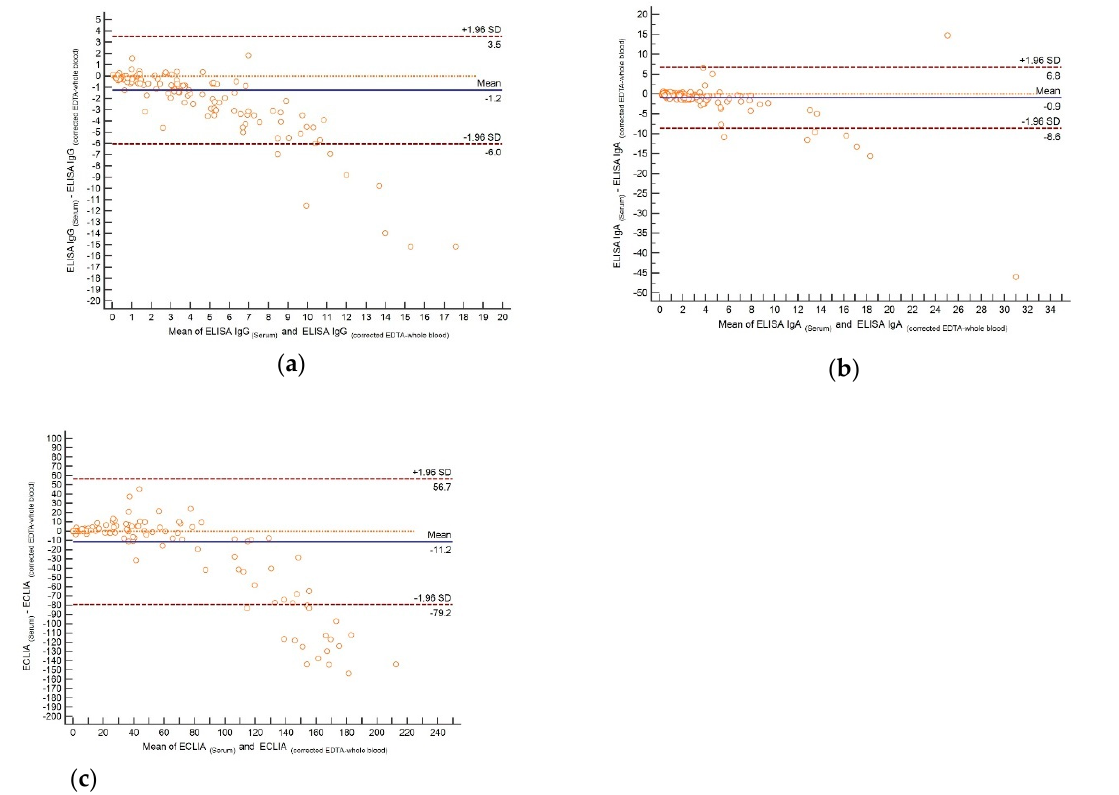
Figure 1. The Bland–Altman plot for assessing comparability of the results obtained in serum and EDTA-whole blood corrected for hematocrit in different assays: ( a ) IgG ELISA, ( b ) IgA ELISA, and ( c ) ECLIA.